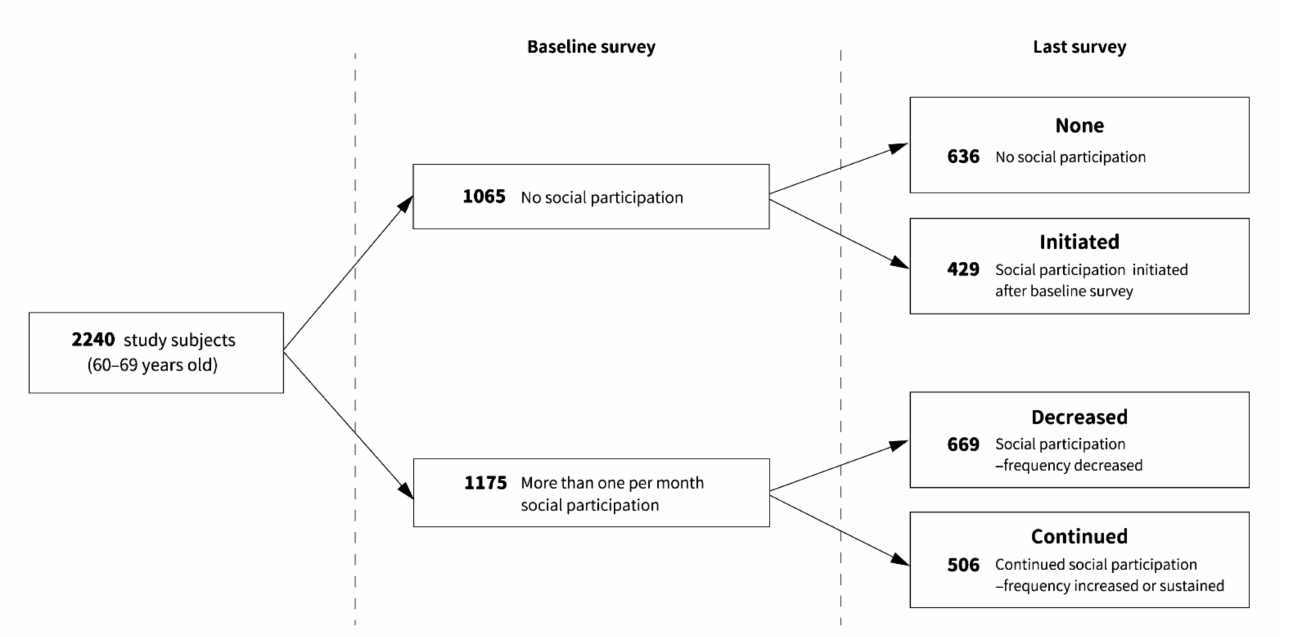
Figure 1. Flow diagram of the frequency pattern of social participation in the study participants. The percentage of missing values across the six variables varied between 0.1 and